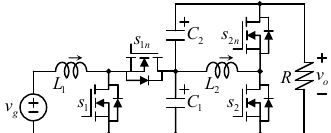
Figure 11. Former operation mode with C1 = 20 µF and C2 = 10 µF vs. the proposed operation mode with C 1 = 6.8 µF and C 2 = 3.3 µF.